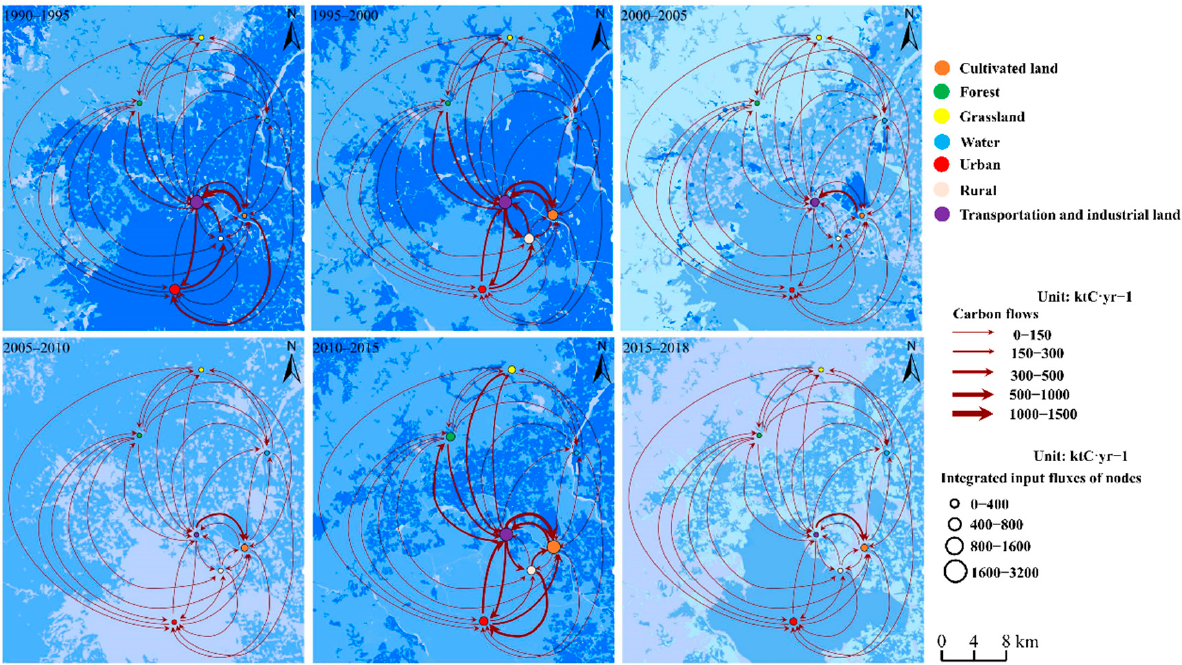
Figure 4. Spatial distribution of integrated carbon flows during each period (the flows that are shown account for at least 80% of the total flows). Note: the flows related to bare land were too small to show in the figure.